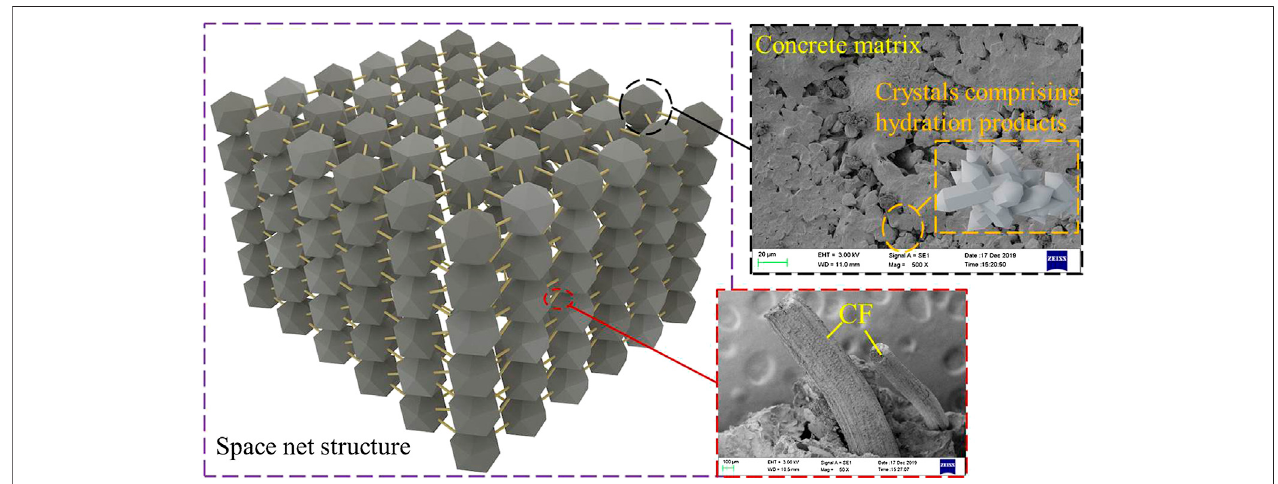
FIGURE 8 | Space net